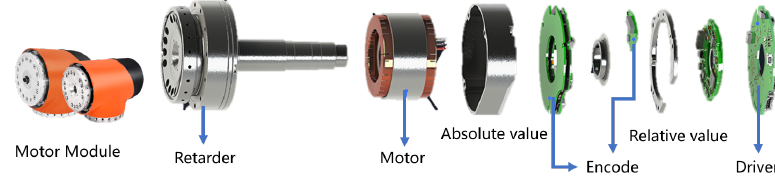
Figure 8. Composition of motor